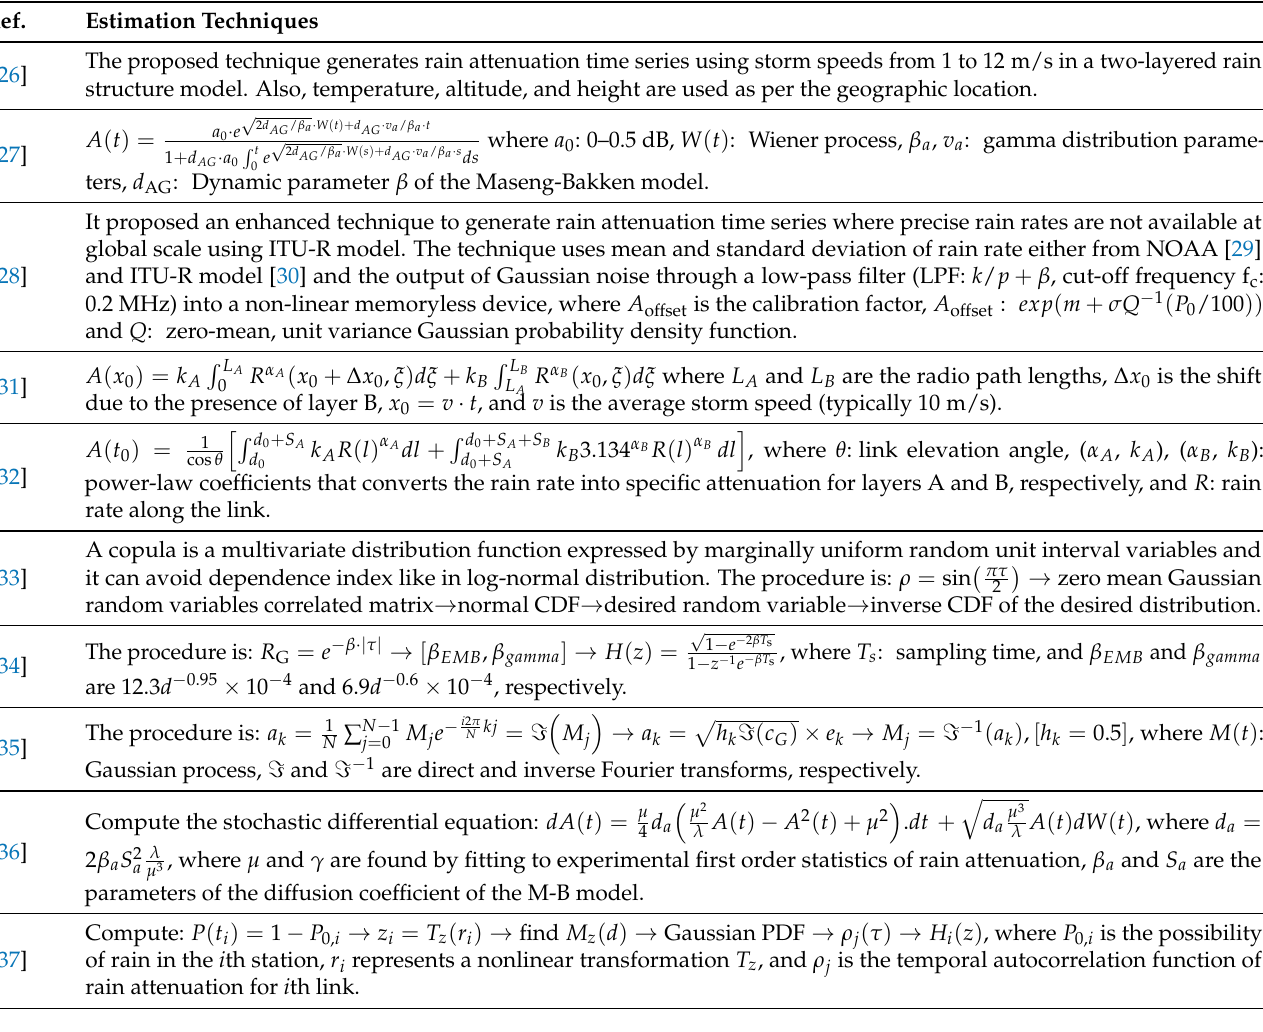
Table 1. Estimation techniques of rain attenuation time series.